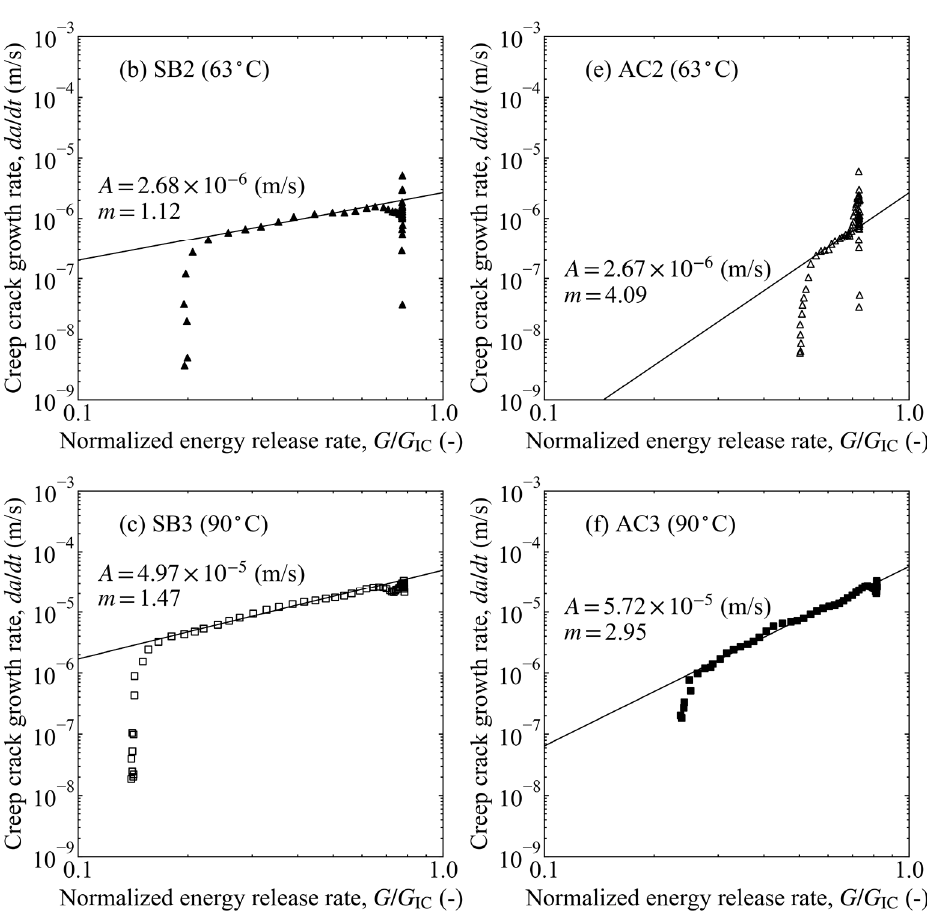
Figure 13. Creep crack growth relationship between the creep crack growth rate and normalized energy release rate at different temperatures and surface treatments: ( a – c ) sandblasting; ( d – f ) pickling at 32, 63, and 90 ◦ C, respectively. A magnified graph is included in ( d ). The light-green arrows in ( a ) and ( d ) are the failure mode changing points, which relate to the locations of the light-green triangles in Figure 11.